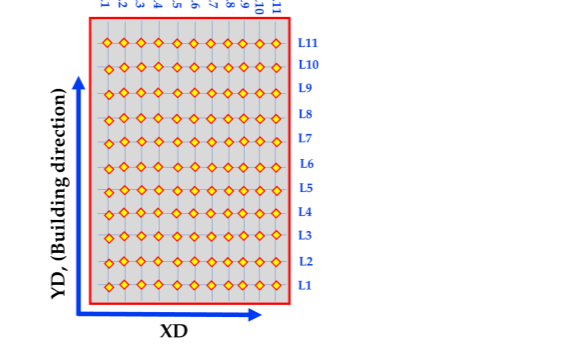
Figure 5. Sketch of hardness map measurements of AMPs and AMCs.